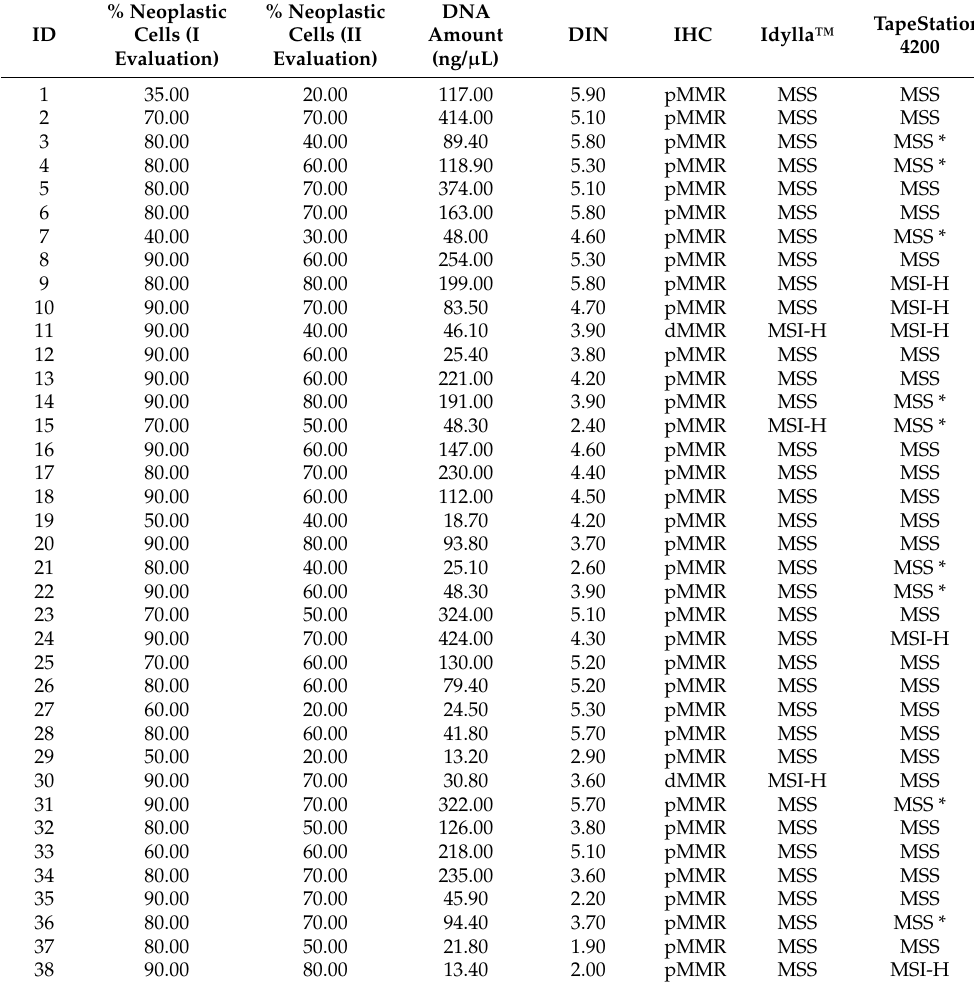
Table 2. Summary of molecular analysis of MMR/MSS status for ovarian cancer patients.